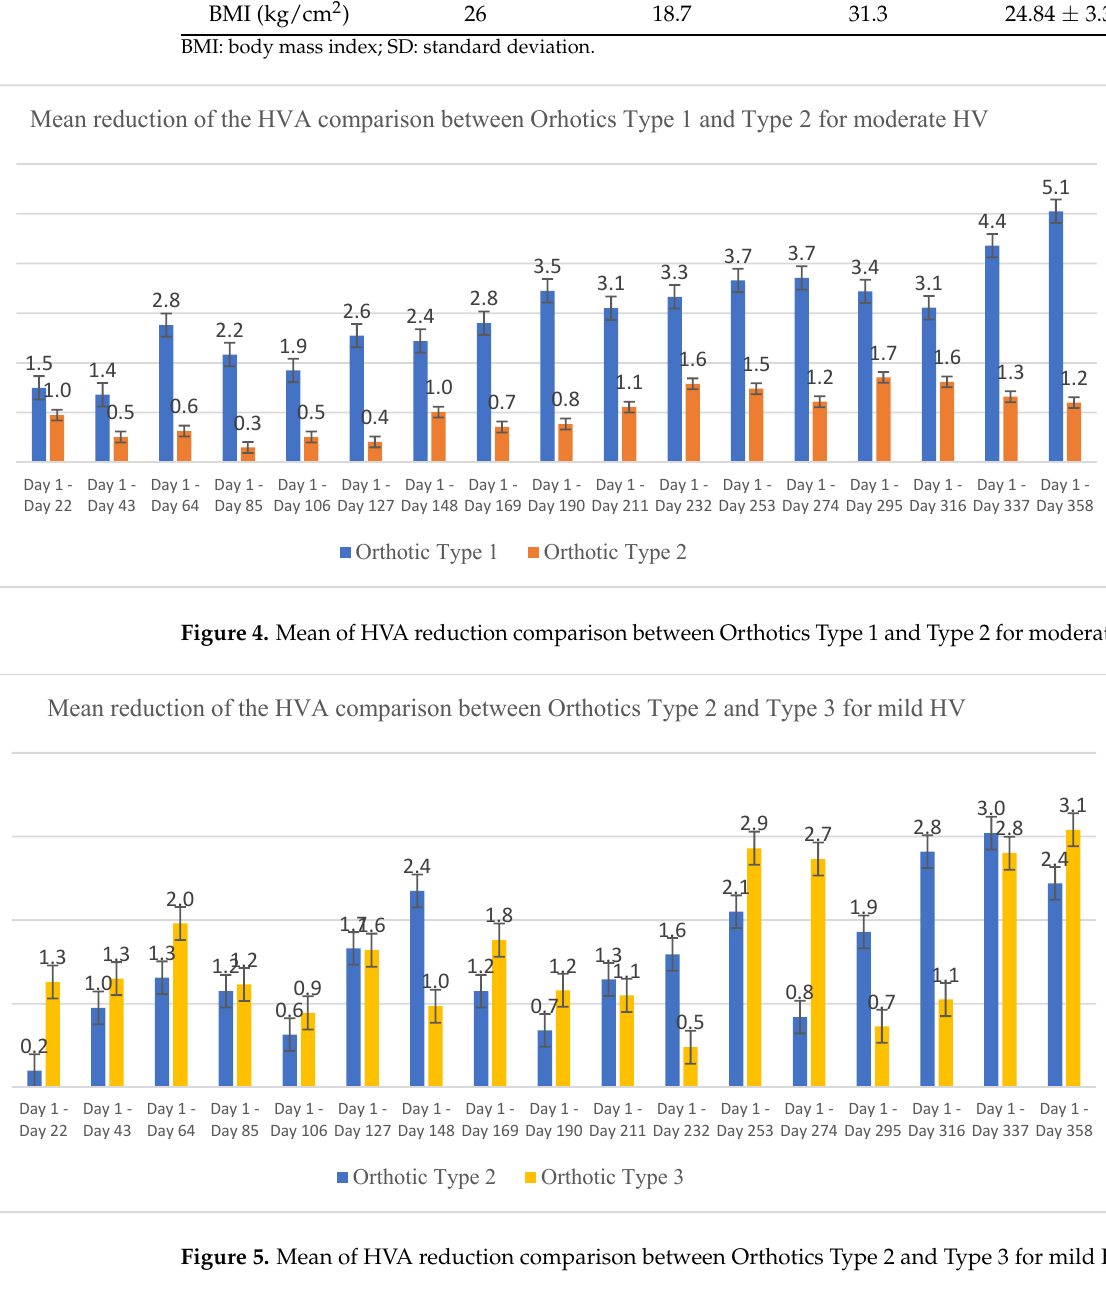
Table 2. Comparison of three orthotics in correction of HVA over a 12-month treatment including 95% confidence interval of the difference and p -value.